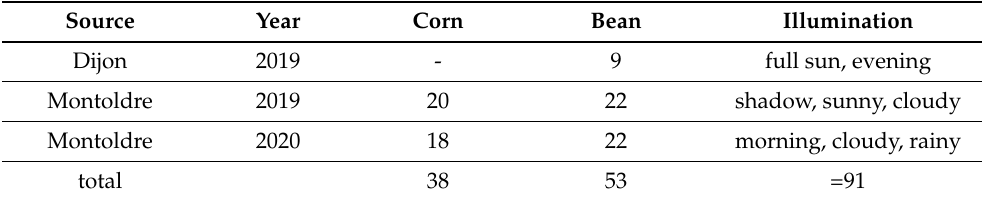
Table 1. Acquisition sources and global